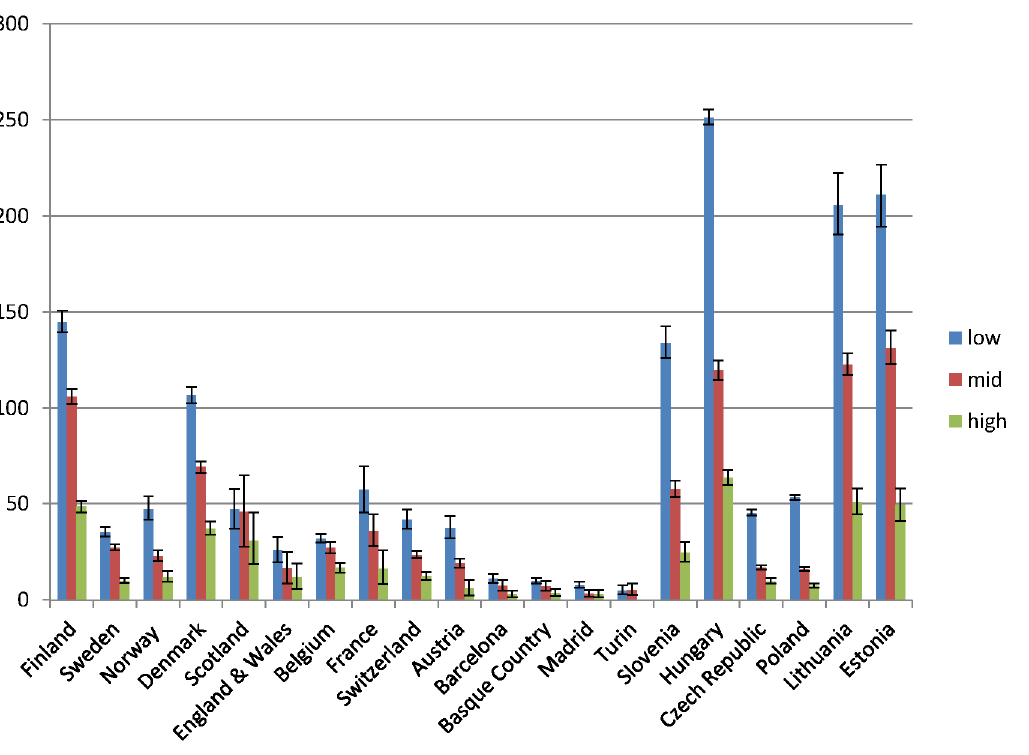
Fig 1. Latest observed mortality from alcohol-related causes among men aged 35 – 79 y, by population and level of education. The y- axis shows alcohol-related mortality, with 95% CIs, in deaths per 100,000